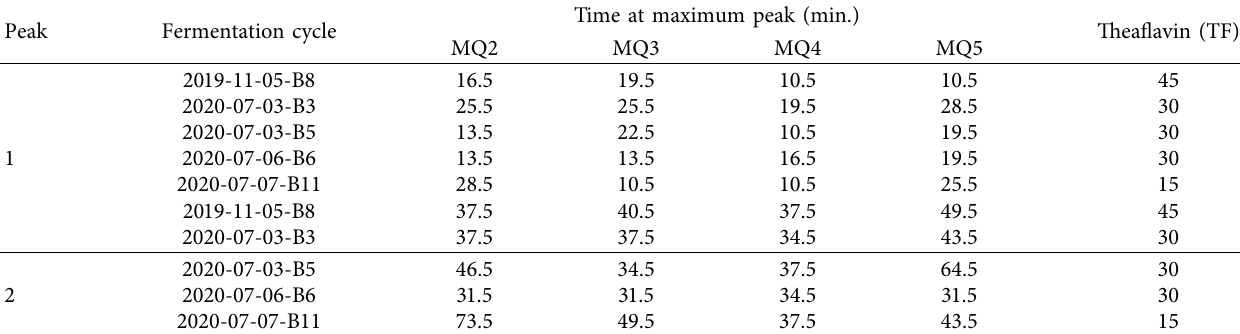
Time at maximum peak (min.)